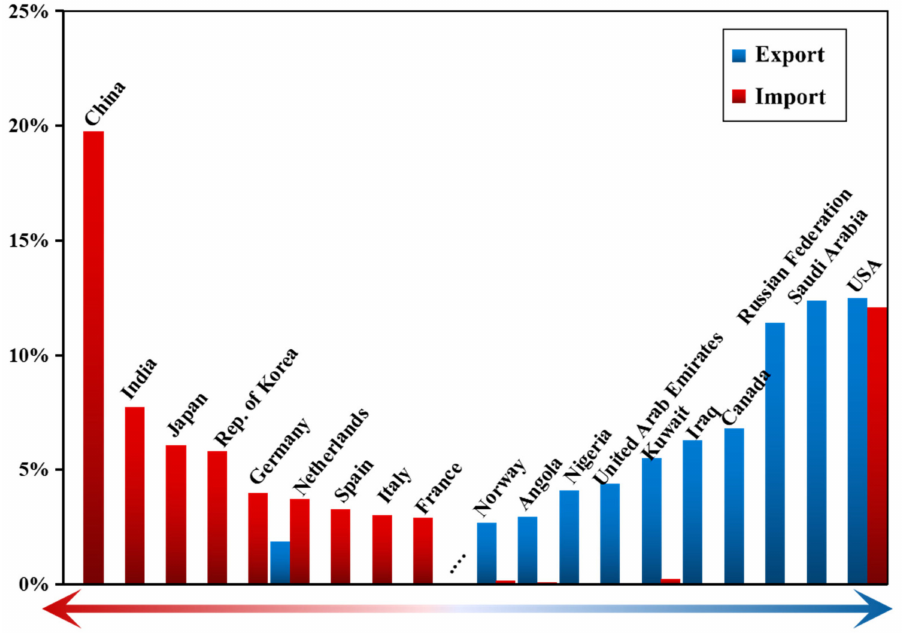
Figure 2. Major crude oil trade countries and the share of imports and exports in